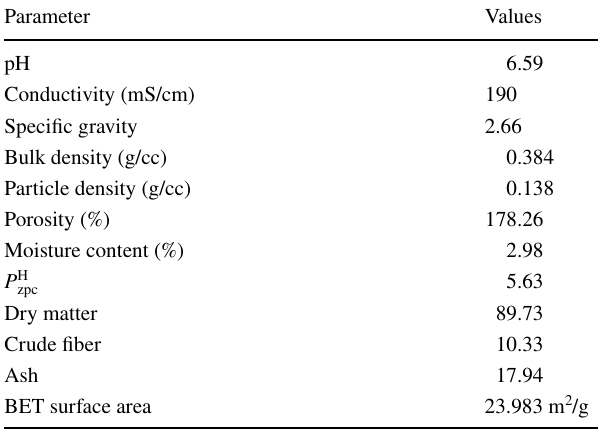
Table 1 Physical characteristics of banana